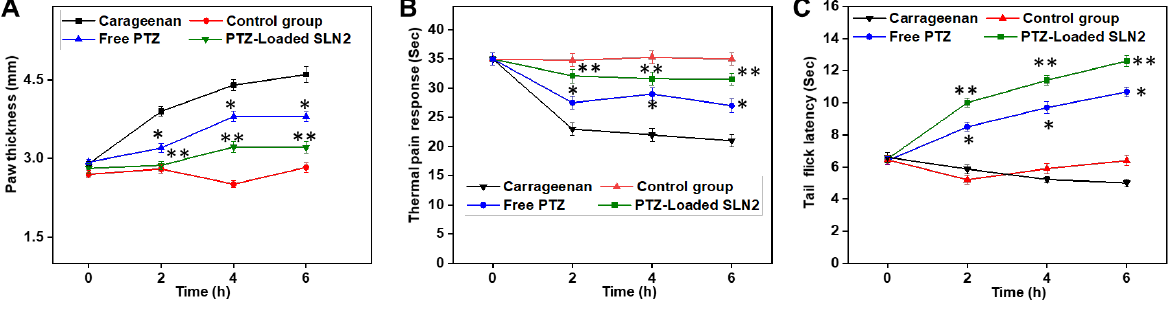
Figure 7. Effects of PTZ-SLN2 on the paw edema of Wistar rats (N = 20 rats, n = 5/group) following carrageenan-induced inflammatory pain. The experiments were conducted for 6 h. ( A ) Impact on paw thickness (mm); ( B ) Impact on thermal analgesia (sec); ( C ) Impact on tail flick latency (sec). Control group 1 (1 × PBS, orally administrated), carrageenan group 2 (200 µ L/paw of the 1% w / v solution, single injection), free PTZ group 3 (carrageenan 200 µ L/paw of the 1% w / v solution + free PTZ orally administrated at 5 mg/kg), and PTZ-loaded SLN2 group 4 (carrageenan 200 µ L/paw of the 1% w / v solution + PTZ-loaded SLN2 orally administrated at 5 mg/kg). The carrageenan was administered 30 min into the Groups 3 and 4 before the treatment (with free PTZ and PTZ-loaded SLN2, respectively). The carrageenan group showed a drastic increase in the paw thickness and hyperalgesia when compared to the (vehicle) control group, which were significantly reduced in the free PTZ and, in a larger extent, PTZ-SLN2 groups. Data are expressed as mean ± SD (n = 3). * p < 0.05 and ** p < 0.01 represent mild and moderate statistical significance, respectively, when compared to the carrageenan group.